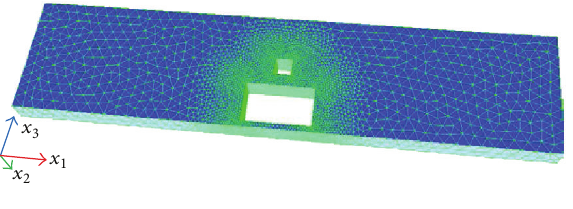
Figure 5: IBDD versus BDD.